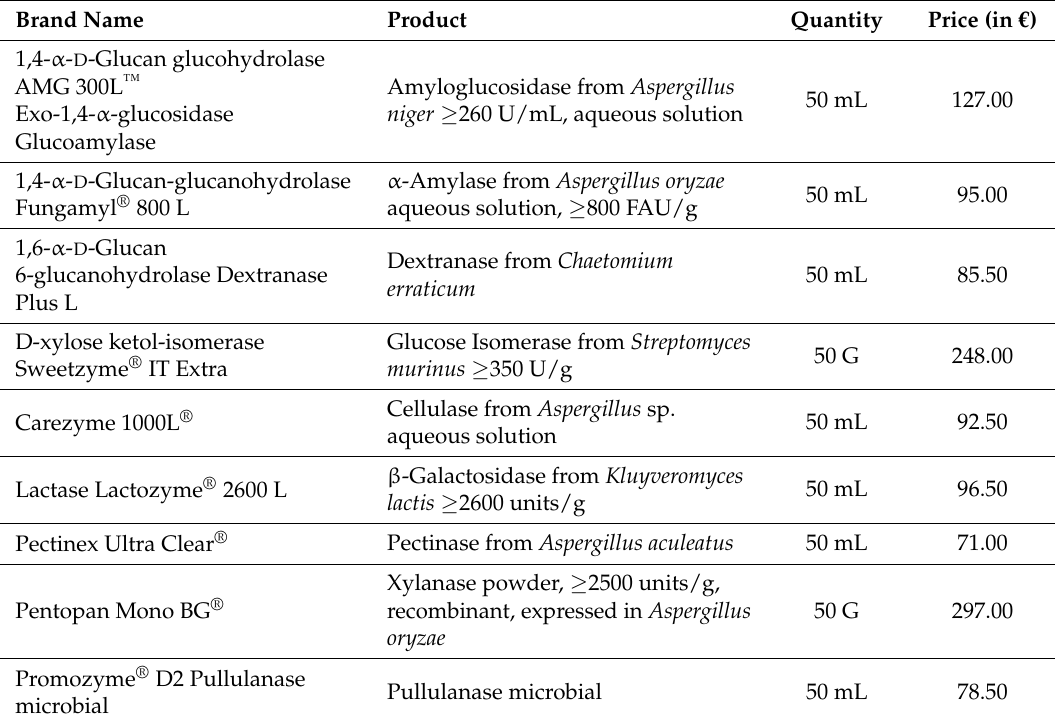
Table 2. Price of some of the commercially important cellulytic enzymes